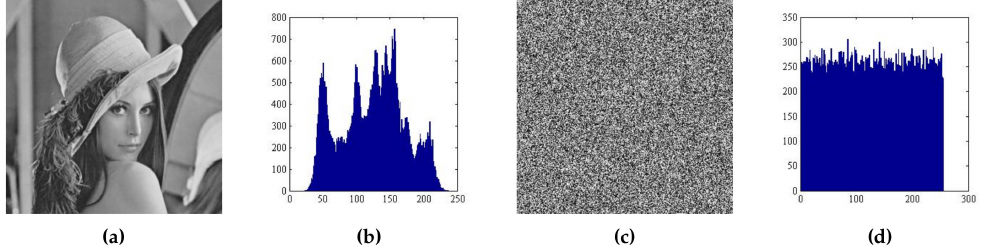
Figure 9. Result of Lena image. ( a ) Lena image, ( b ) histogram of Lena image, ( c ) encrypted Lena, and ( d ) histogram of encrypted Lena.